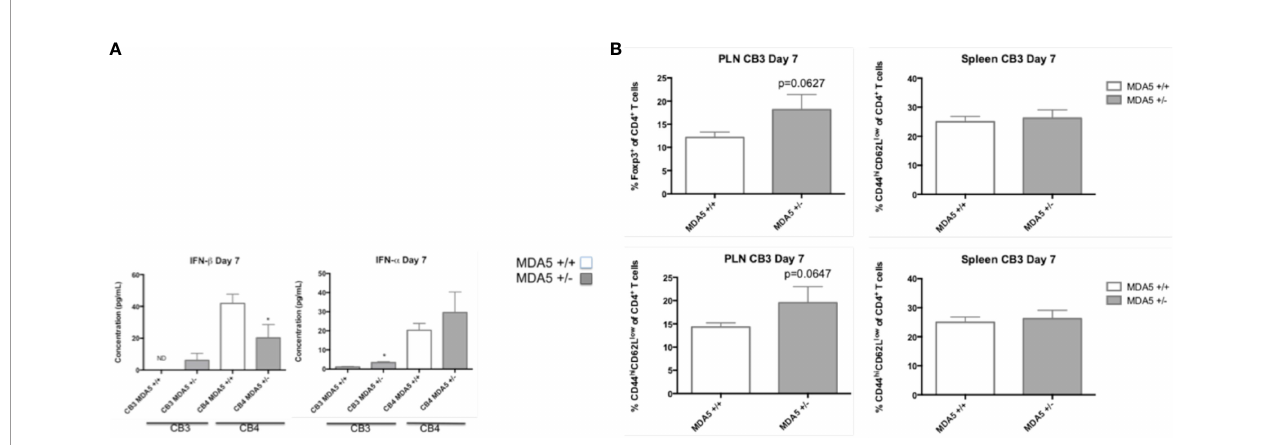
FIGURE 3 | Serum levels of IFN-I and CD4 + T cell responses in MDA5 +/- and MDA5 +/+ mice after CB3 and CB4 infection. (A) IFN- a / b In fl ammatory cytokine concentrations (pg/mL) were measured from CB4 and CB3 infected MDA5 +/- (n = 7) and MDA5 +/+ (n = 7) mice sera by ELISA. (B) Regulatory T cells (Foxp3 + CD4 + ) and effector T cells (CD44 hi CD62 low CD4 + and IFN g -producing CD4 + ) were isolated from the pancreatic lymph nodes (PLNs) and spleens of CB3 infected MDA5 +/- (n = 5) and MDA5 +/+ (n = 5) mice at day 7 post CB4-infection and were stained with classical activation and maturation marker antibodies for FACS analysis. Results are shown as mean ± SEM of a representative from three independent experiments. *p <